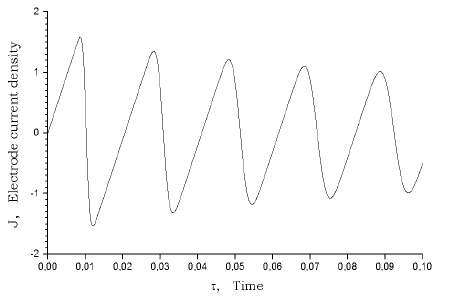
Figure 4. Current density J = J ( τ ) at the electrode surface. Non-electroneutral